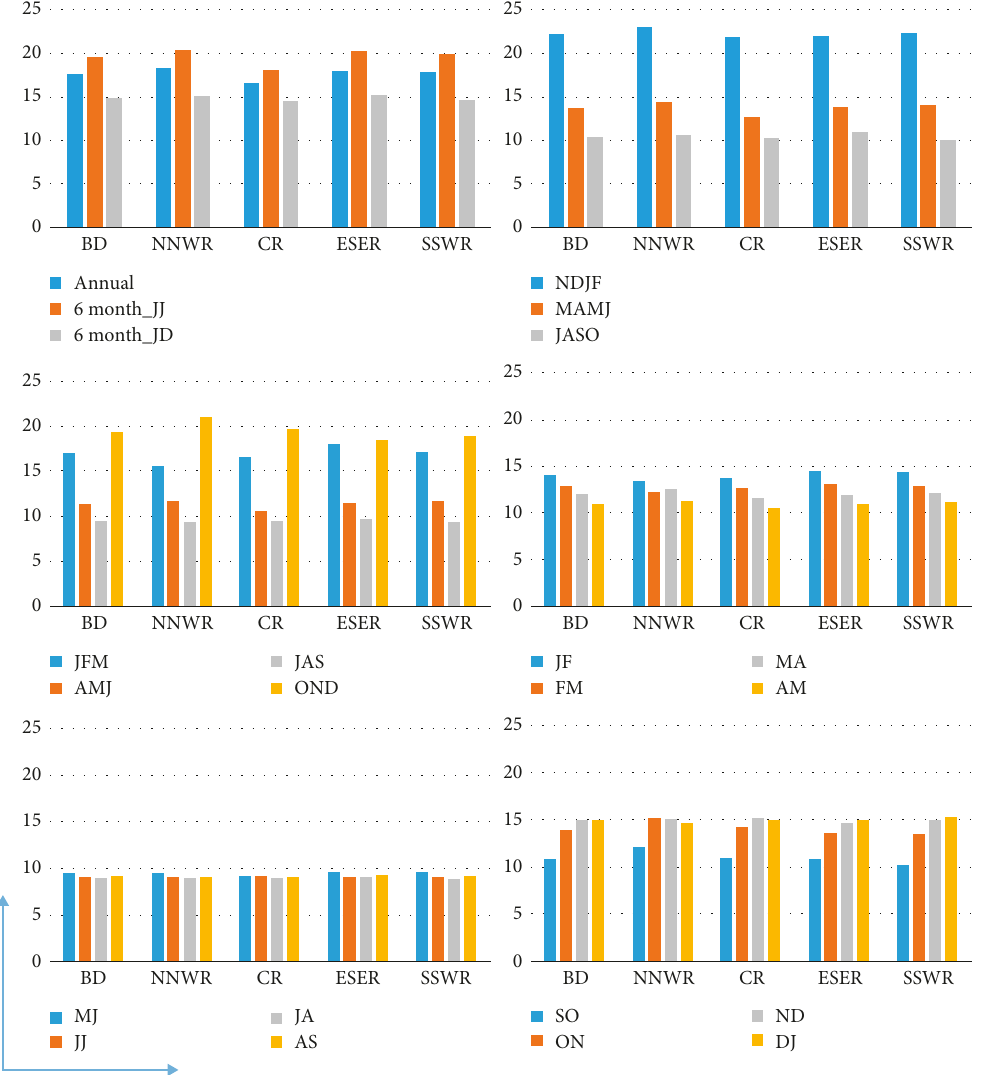
Figure 2: Mean PCI values during 1980–2011. BD, Bangladesh; NNWR, north-northwest region; CR, central region; ESER, east-southeast region; SSWR, south-southwest